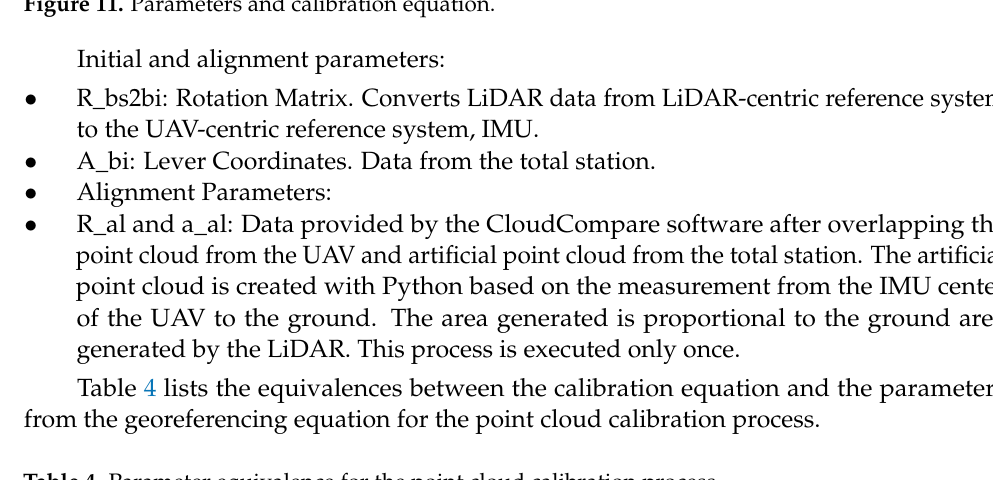
Table 4. Parameter equivalence for the point cloud calibration